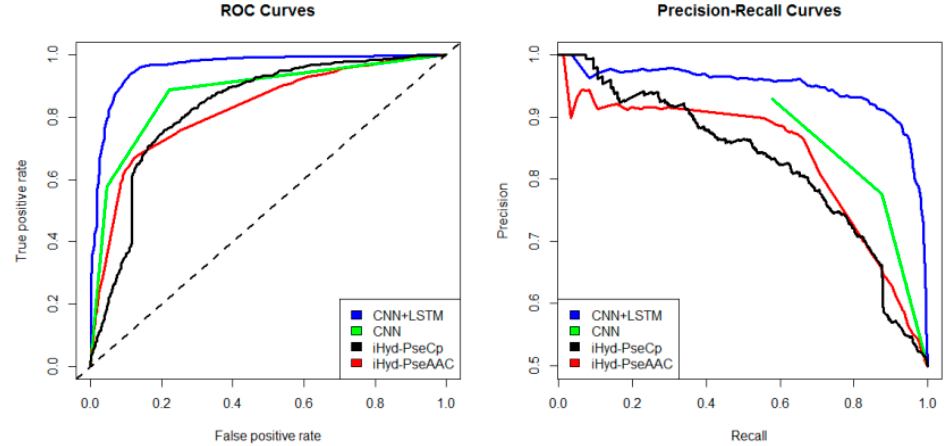
Figure 5. The ROC and Precision-Recall curves to show the performance of CNN+LSTM, CNN, iHyd-PseCp and iHyd-PseAAC for the peptide samples with the center residue being proline on Dataset 4.